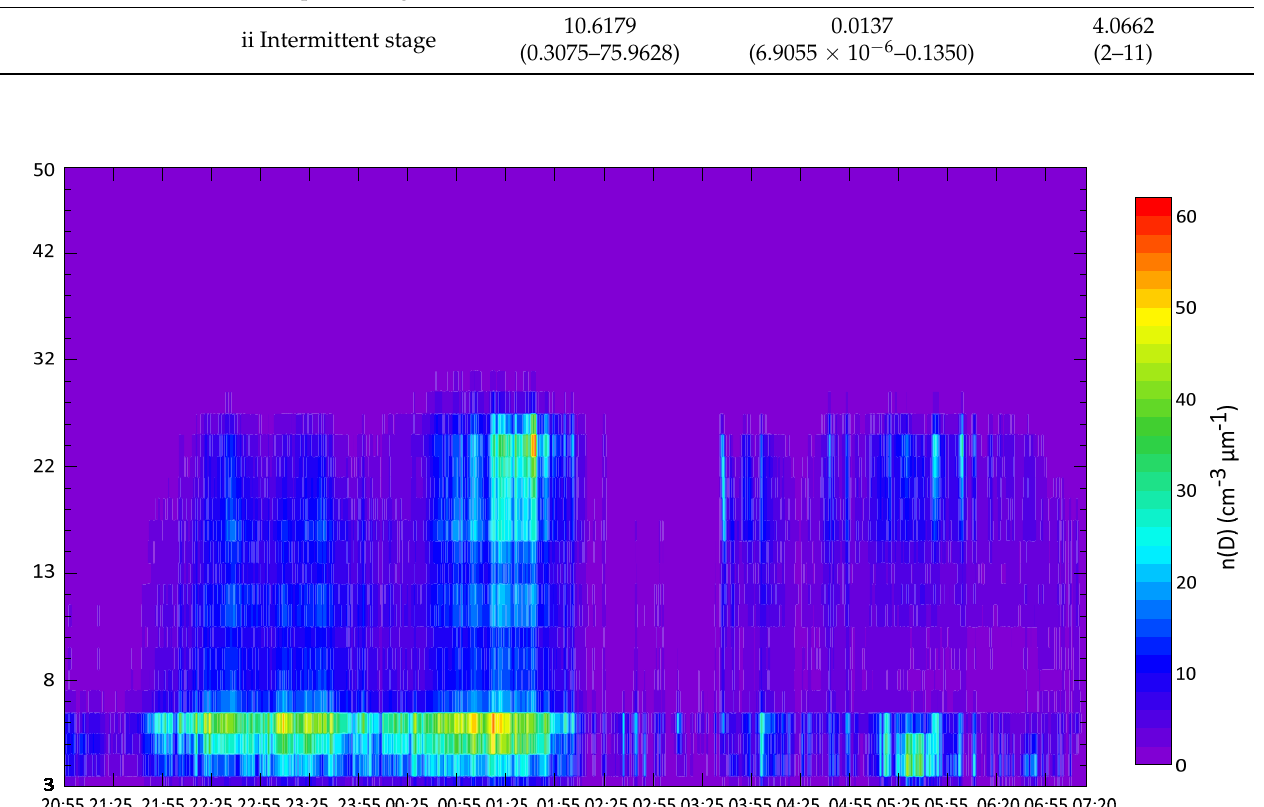
Figure 7. Change in particle number concentration (color-filled) with different diameters over time from 20:55 on 14 June to 7:20 on 15 June